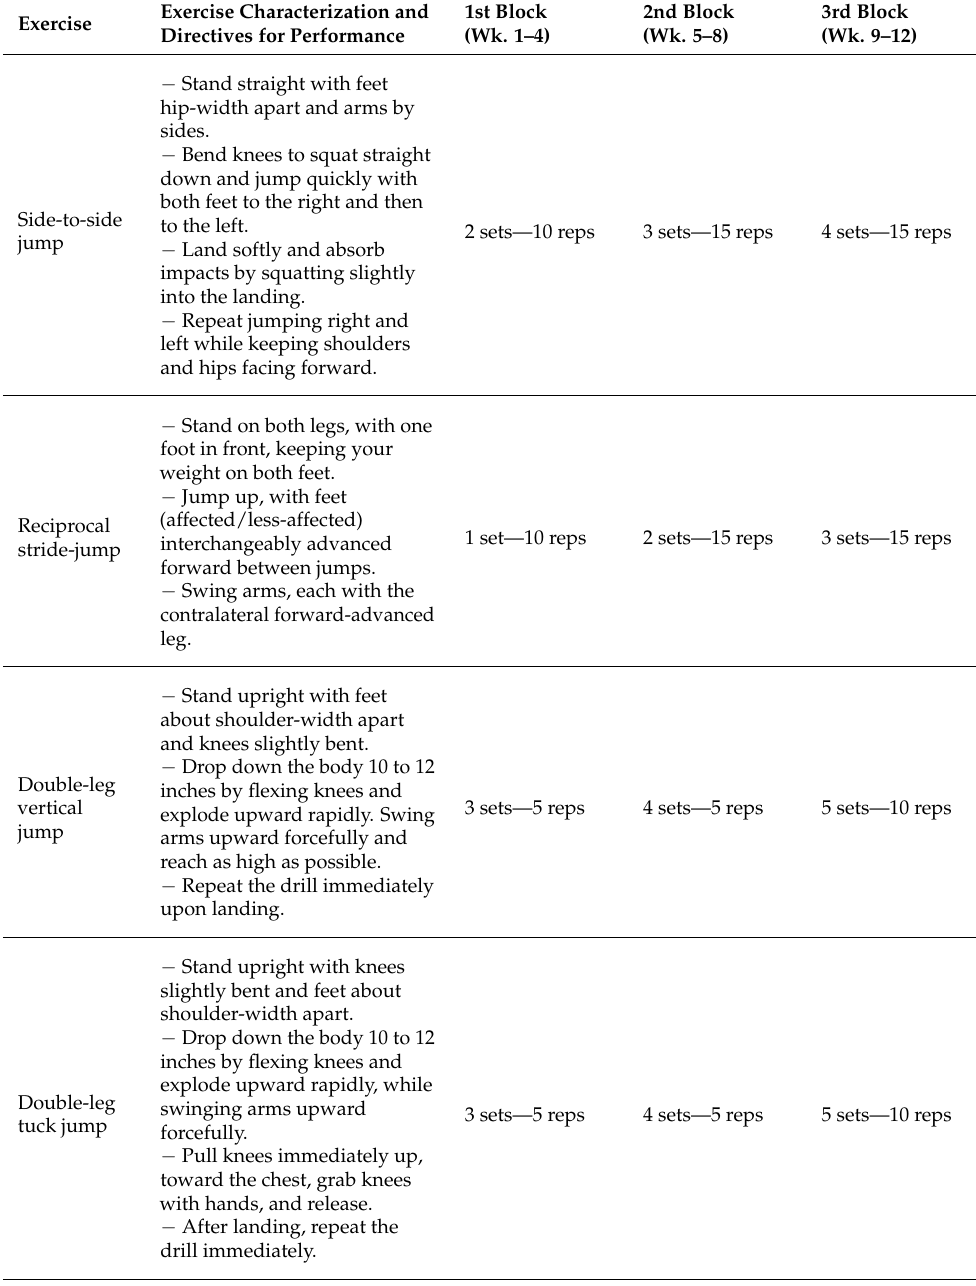
Table 1. Cont. Exercise Characterization and Exercise Directives for